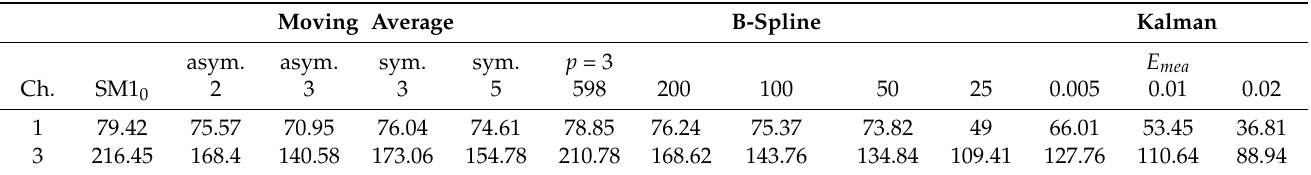
Table 4. The values of the SM1 performance metric for moving average, B-spline, and Kalman filters for signals from channels 1 and 3 of the root-joint for the kicking model using various control